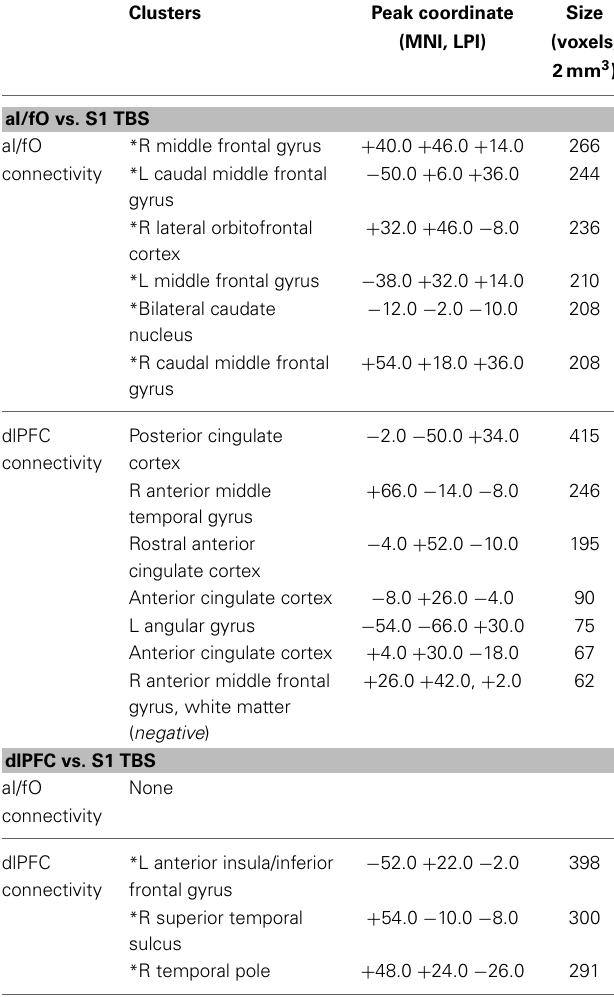
Table 3 | Clusters showing significantly different changes in connectivity after TBS to different